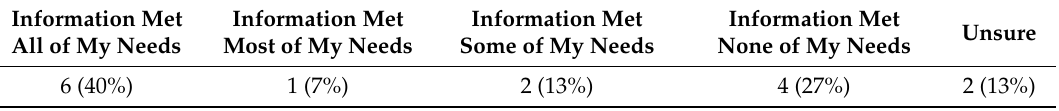
Table 1. Post-stroke information and patient